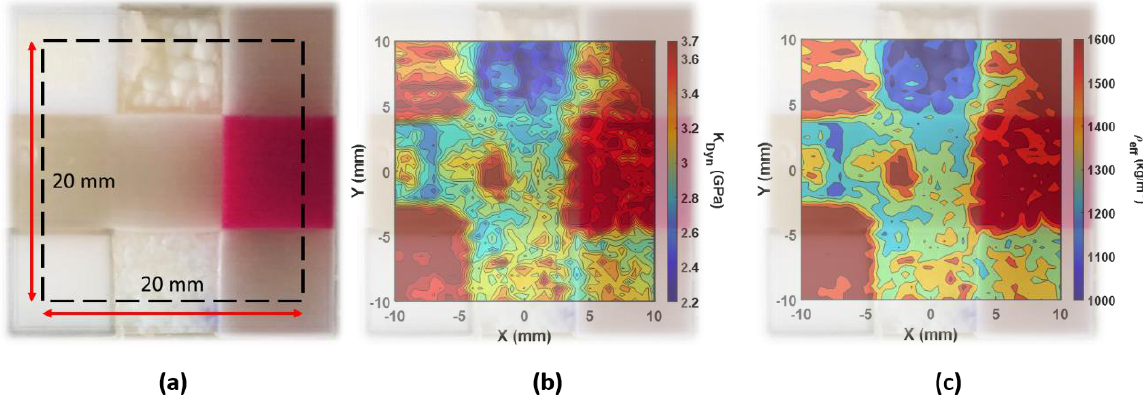
Figure 4. ( a ) The photograph of the 3D printed sample consisting of nine different materials described in Figure 2. The scanned area is depicted with the dashed line (20 mm × 20 mm). ( b ) The dynamic bulk modulus elastography, ranging from 2.2 GPa to 3.7 GPa, overlapped with the photograph of the sample. ( c ) The effective density distribution map, ranging from 1176 kg/m 3 to 1625 kg/m 3 , overlapped with the photograph of the sample. Table 1. Summary of the comparison of material properties between EBME results, such as dynamic bulk modulus, effec- tive density and average speed of sound, and reference values, such as elastic modulus and polymerized density, given by the provider, Stratasys [ 35 ].